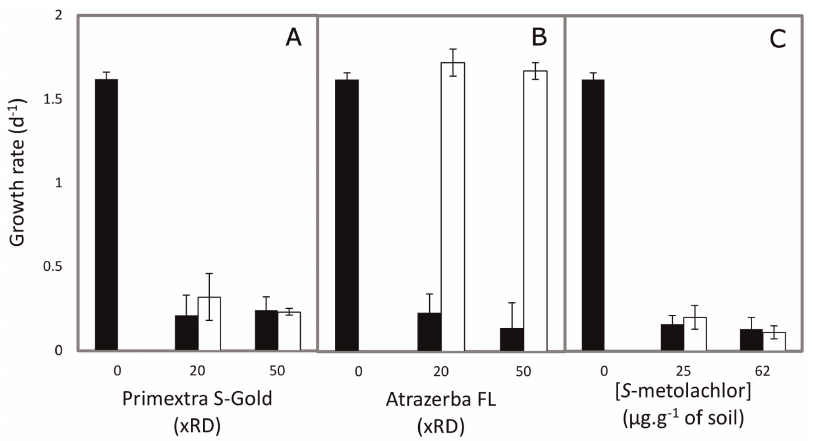
Figure 4. Ecotoxicity of eluates prepared from herbicide-contaminated soil. Mean 72-hours growth rate of Pseudokirchneriella subcapitata on eluates prepared with soil samples collected from microcosms spiked with the indicated doses of ( A ) Primextra S-Gold, ( B ) Atrazerba FL, or ( C ) pure S -MET, at day 5 after soil amendment with Pseudomonas sp. ADP Rif R plus citrate (white columns) or without the bioaugmentation/ biostimulation tool (black columns). Data are means 6 SD from toxicity tests in at least three independent eluate samples.